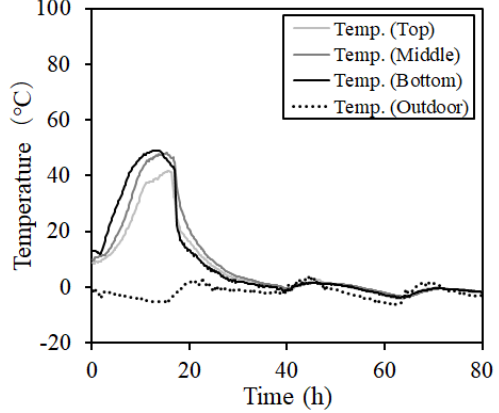
Figure 10. Concrete temperature distribution (ex: MW2).